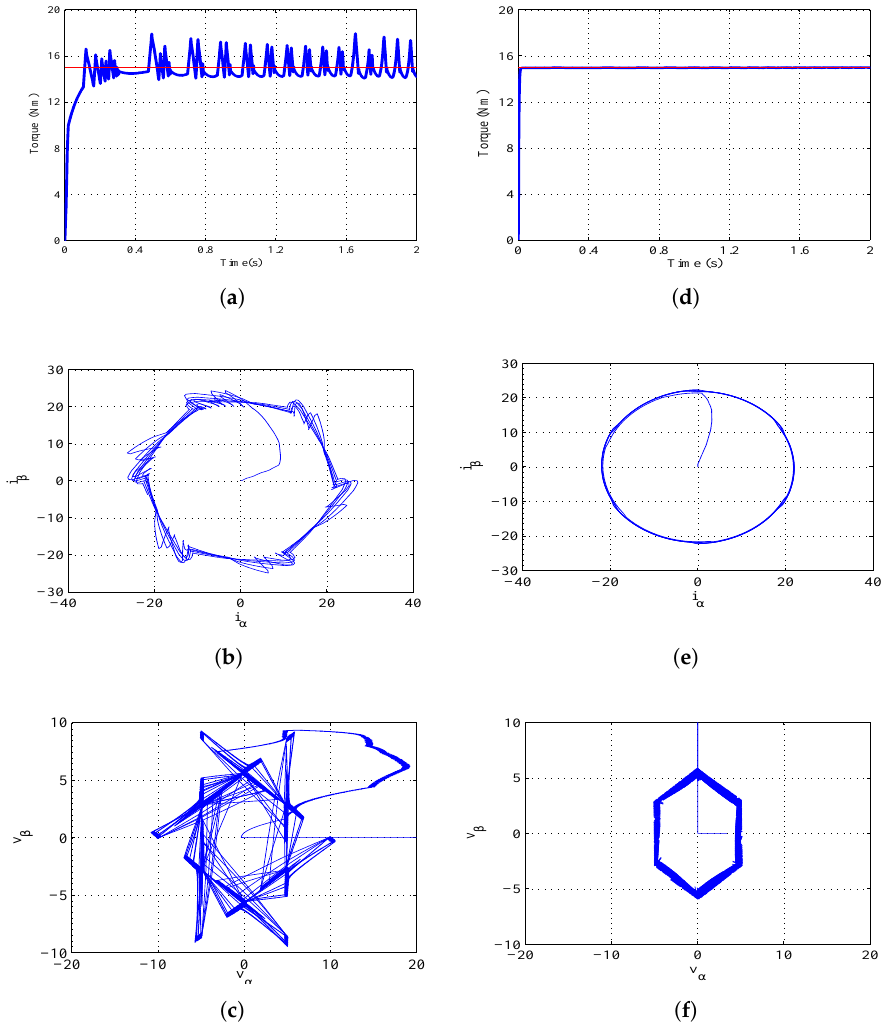
Figure 6. Simulations results: system response under a torque reference of 15 Nm for the two considered parameters sets, with: ( a ) and ( d ) torque; ( b ) and ( e ) trajectories of the stator currents in Concordia coordinates; ( c ) and ( f ) trajectories of the input control voltages in Concordia